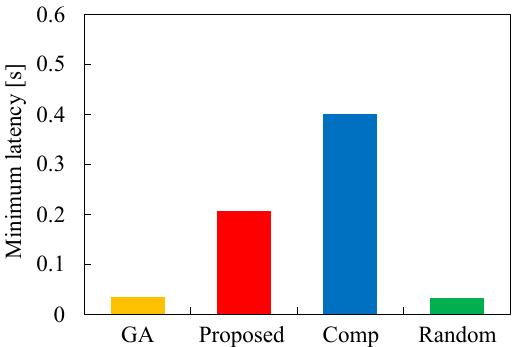
Figure 6. Minimum latency for each method in the case of N 1 = 50, τ = 0.2, and λ = 2.0.